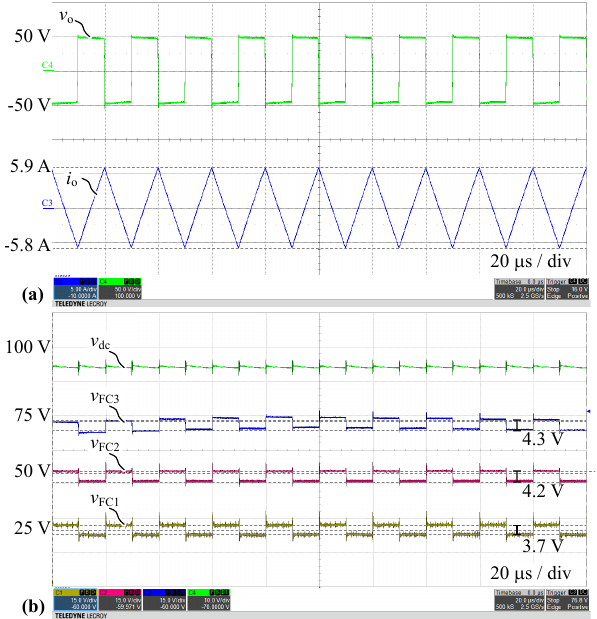
Figure 16. Measured waveforms for Q2L-5L-FCC in configuration 1 (cid:13) with CL balancing and trian- gular current ( I o,max = 5.9A, I o,min = − 5.8A): ( a ) Output voltage v o and current i o , ( b ) DC-link